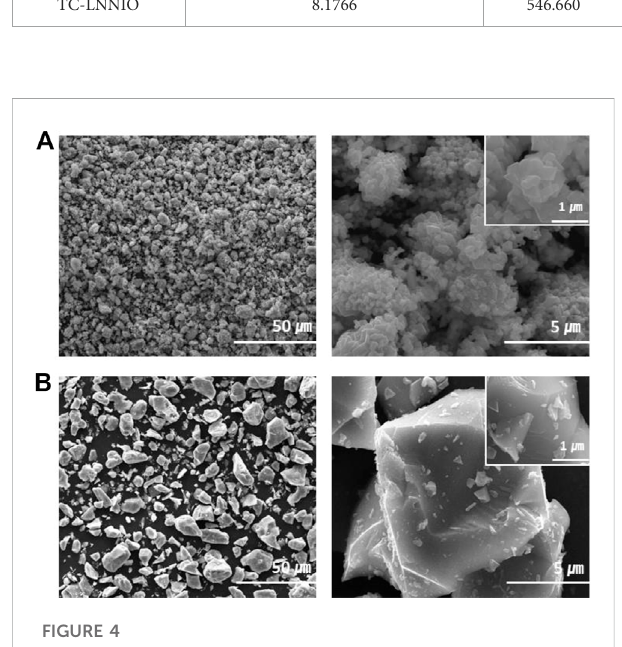
FE-SEM image of (A) synthestic LNMO and (B) commercial